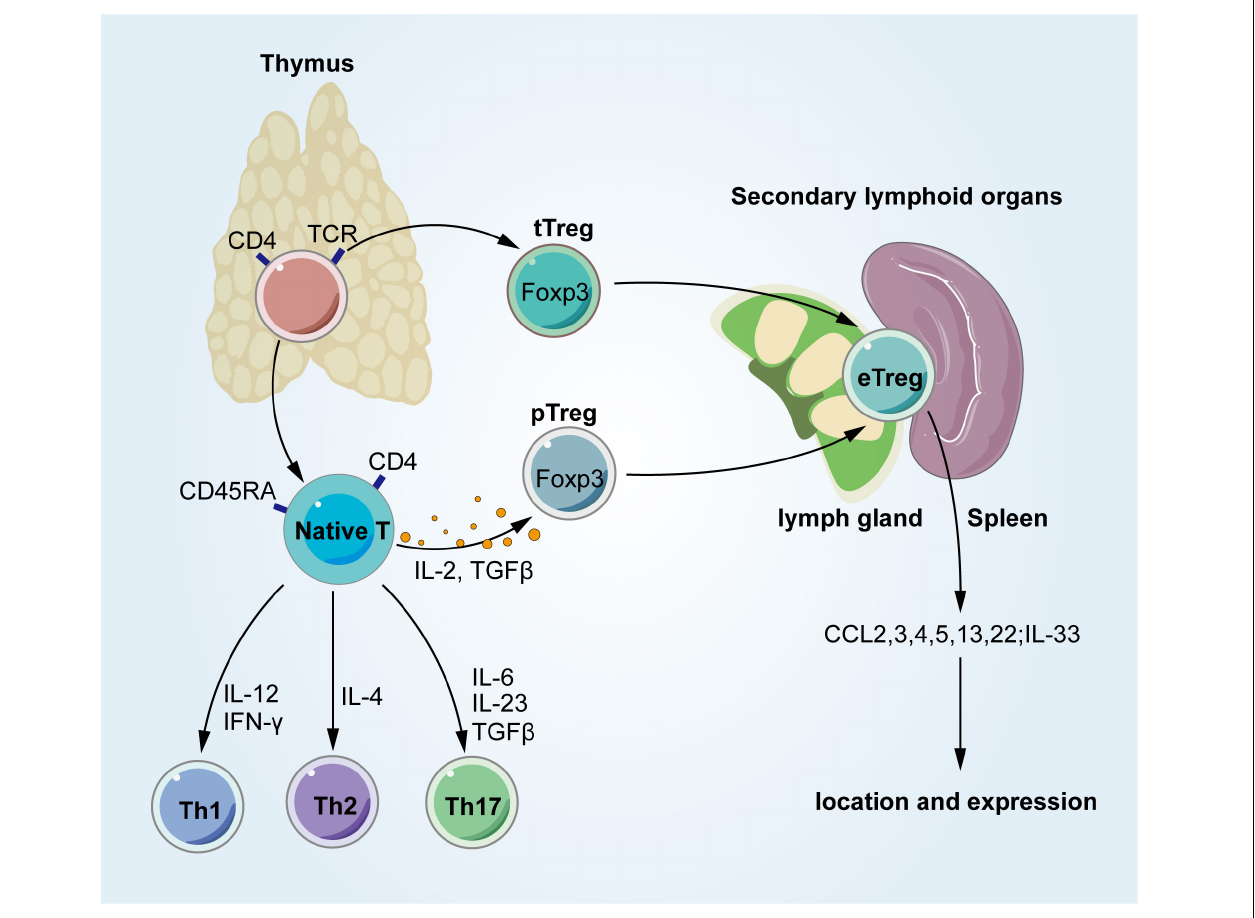
FIGURE 2 | Occurrence and development of tissue Tregs. Derived from the normal thymus, Tregs have two different ways to develop. In the thymus, CD4 + thymocytes turn into tTregs by TCRs. In periphery, Tregs occur with IL-2 and TGF- β . These Tregs stay in SLO, and then migrate into tissues once being stimulated. Tregs, regulatory T cells; tTregs, thymic Tregs; pTregs, peripheral Tregs; TCR, T cell receptors; Th1, T-helper 1; Th2, T-helper 2; Th17, T-helper 17; IFN- γ , interferon-gamma; TGF- β , transforming growth factor beta; IL-12, interleukin-12; IL-4, interleukin-4; IL-6, interleukin-6; IL-2, interleukin-2; IL-23, interleukin-23; CCL, chemokine (C-C motif)